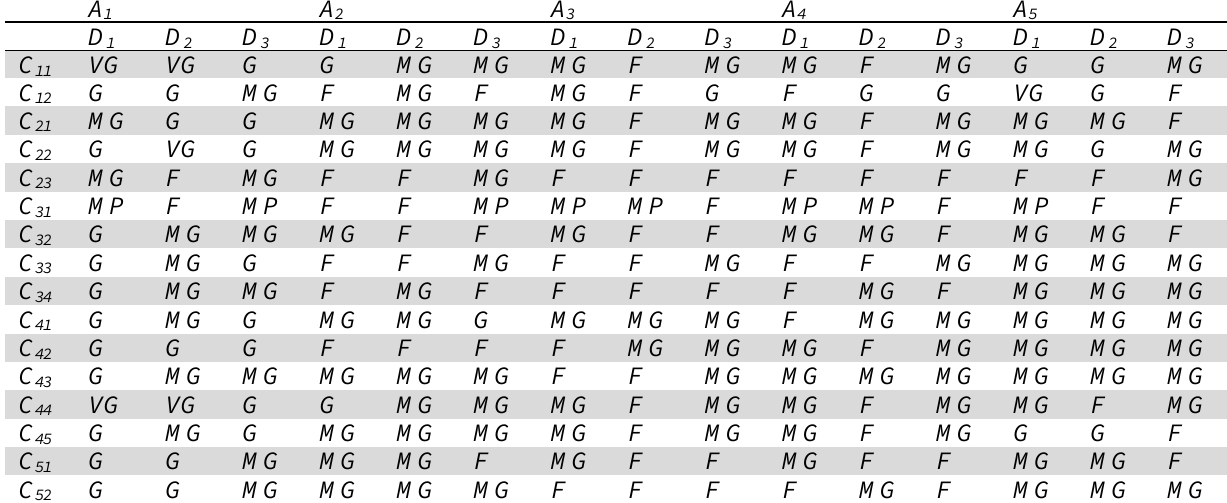
Decision matrix for fuzzy TOPSIS method using fuzzy linguistics variables